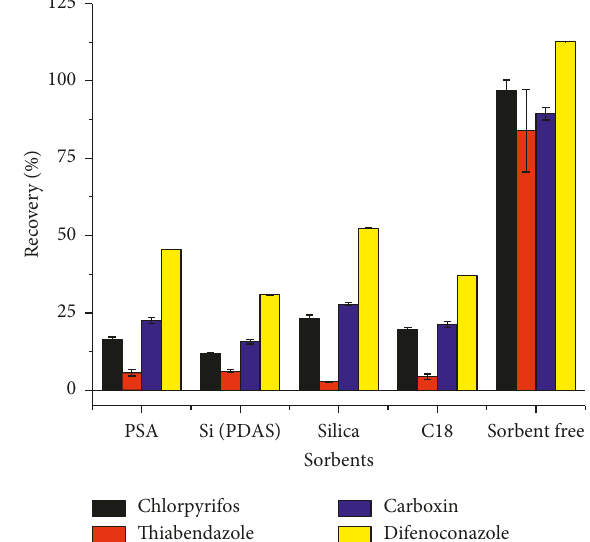
Figure 5: Pesticide residue recoveries in caj´a-manga by the SLE- LTP method after the clean-up step of the extract, using different